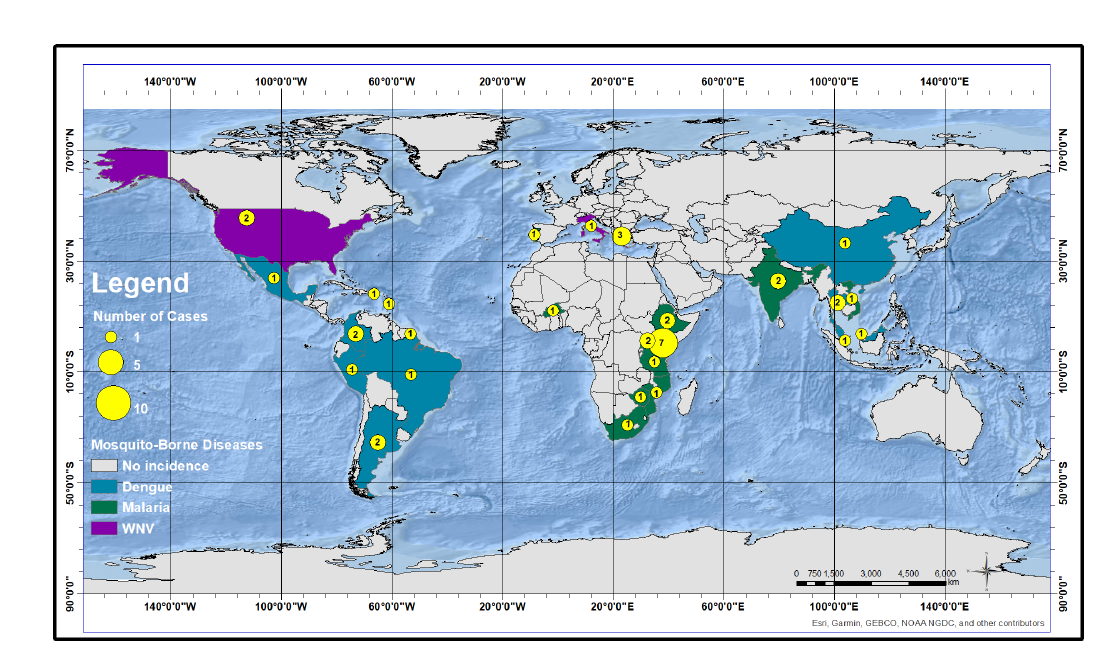
Figure 2. Distribution Map of the MBDs that were included in this